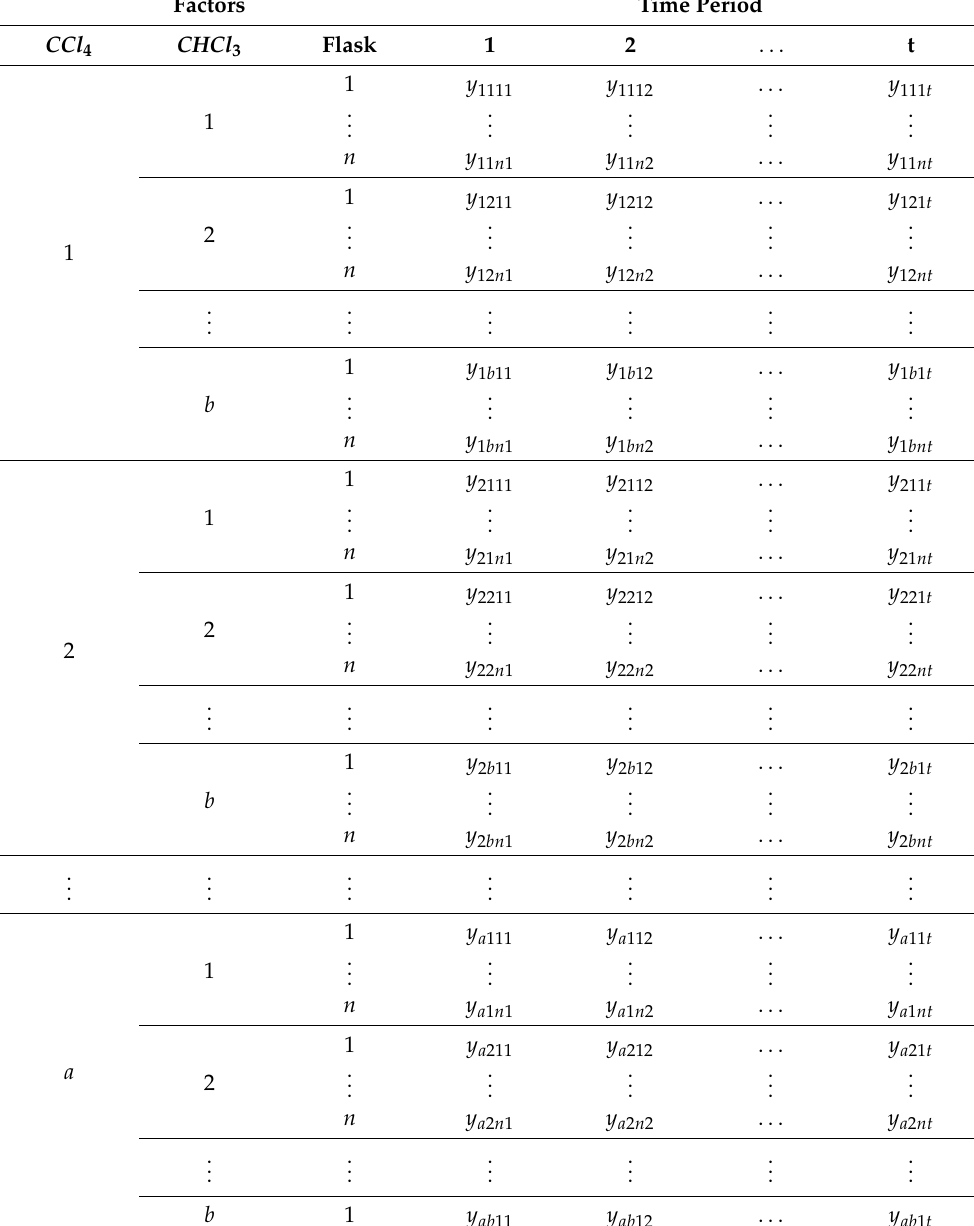
Table 3. Data layout for a three-factor repeated-measures experiment. Factors Time Period CCl 4 CHCl